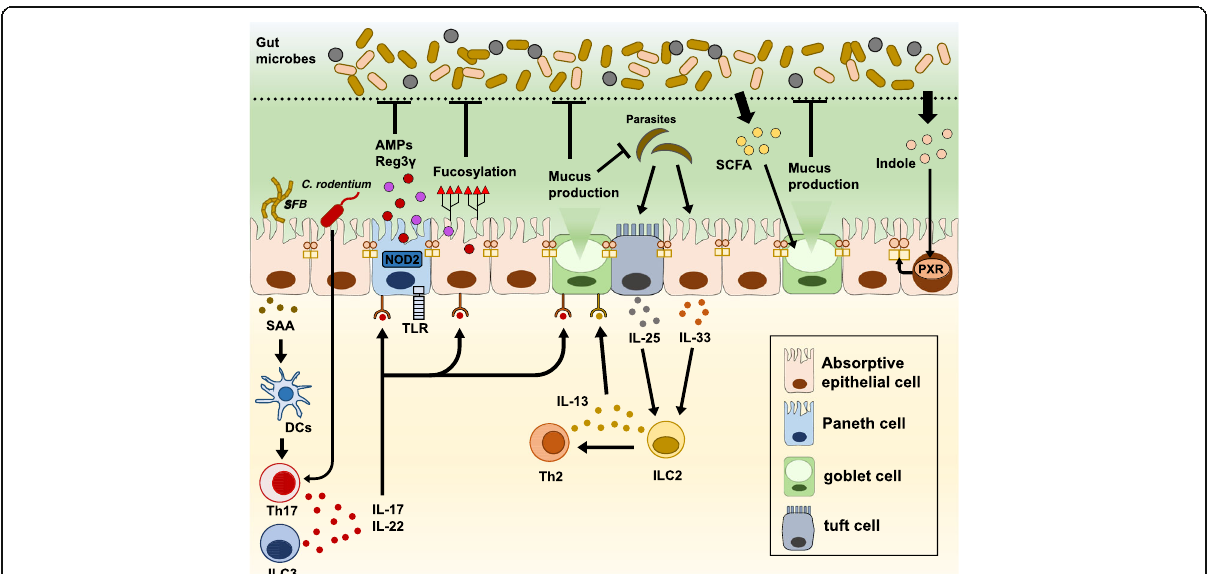
Fig. 2 Regulation of mucosal barrier functions by gut microbes and host immune cells. Mucosal barrier function is modulated by gut microbes and host immune cells. SFB colonization or C. rodentium infection promotes the induction of helper T cells producing IL-17 and simulates ILC3 to secrete IL-22. Both cytokines enhance the production of antimicrobials such as AMPs and Reg3 γ from IECs. In the case of parasite infection, activated tuft cells produce IL-25, which stimulates ILC2 to secrete IL-13. IL-13 promotes the proliferation of goblet cells and mucus production from them. Metabolites from gut microbes also directly influence the mucosal barrier function of IECs. SCFA promotes mucus production from goblet cells, and indole upregulates the expression of cell junction-related molecules through PXR activationSFB: segmented filamentous bacteria, SAA: serum amyloid A, ILC: innate lymphoid cell, TLR: Toll-like receptor, NOD2: nucleotide-binding oligomerization domain-containing 2, AMP: antimicrobial peptide, IEC: intestinal epithelial cell, SCFA: short-chain fatty acid, PXR: Pregnane X